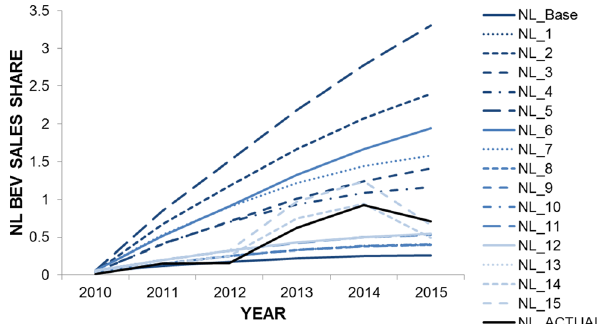
Fig. 2 NL BEV sales shares under scenario conditions detailed in Table 3 and actual sales detailed in Table 2